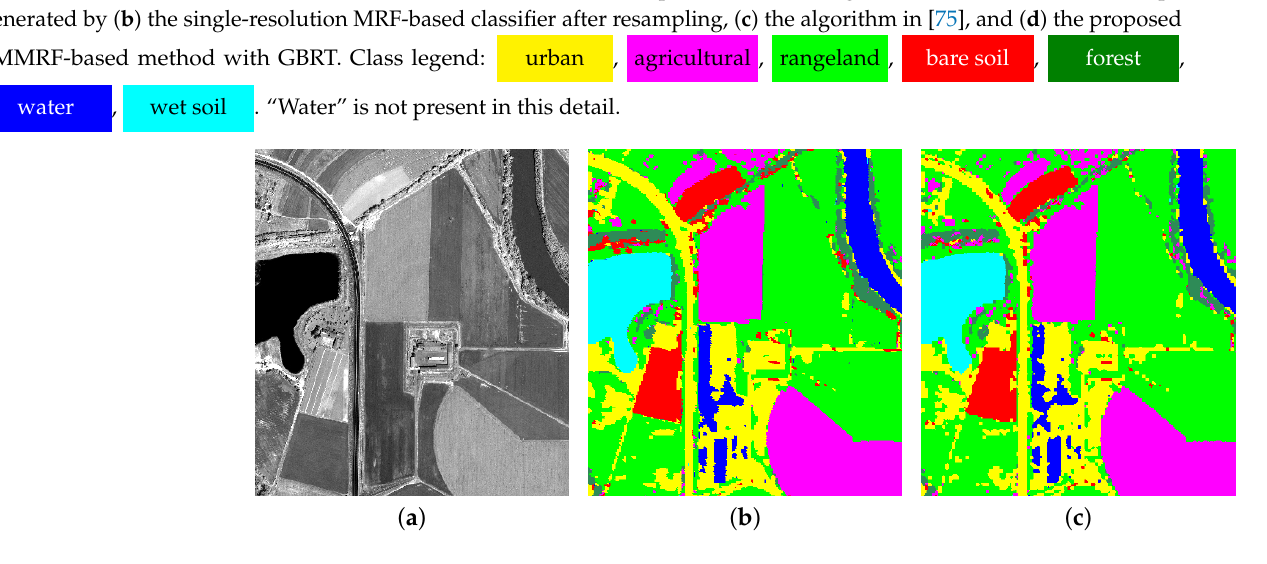
Figure 9. “Alessandria” dataset: details of ( a ) the 1 m resolution panchromatic image and the classification maps generated by ( b ) the proposed SMMRF-based algorithm with GBRT, and ( c ) the proposed MC-based algorithm with the zig-zag and Hilbert curve scan and GBRT. Class